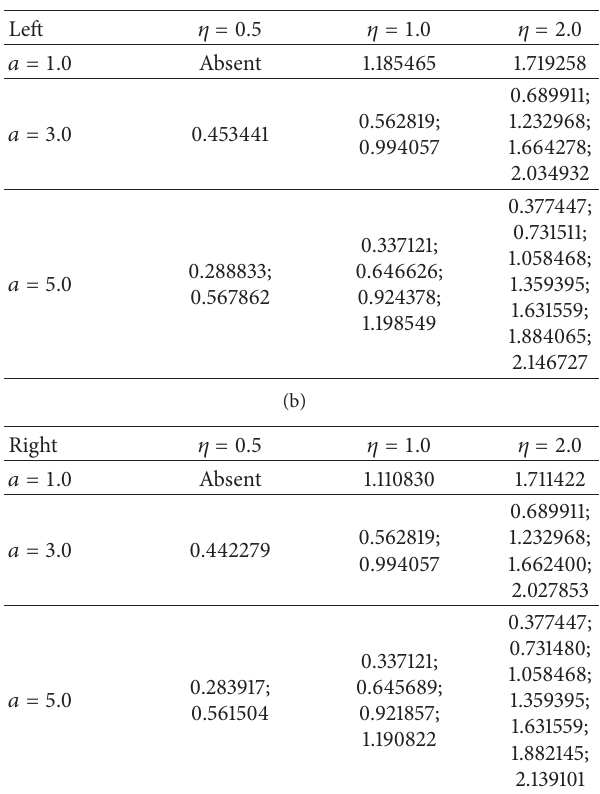
Table 1: Masses of resonances for different values of 𝜂 and 𝑎